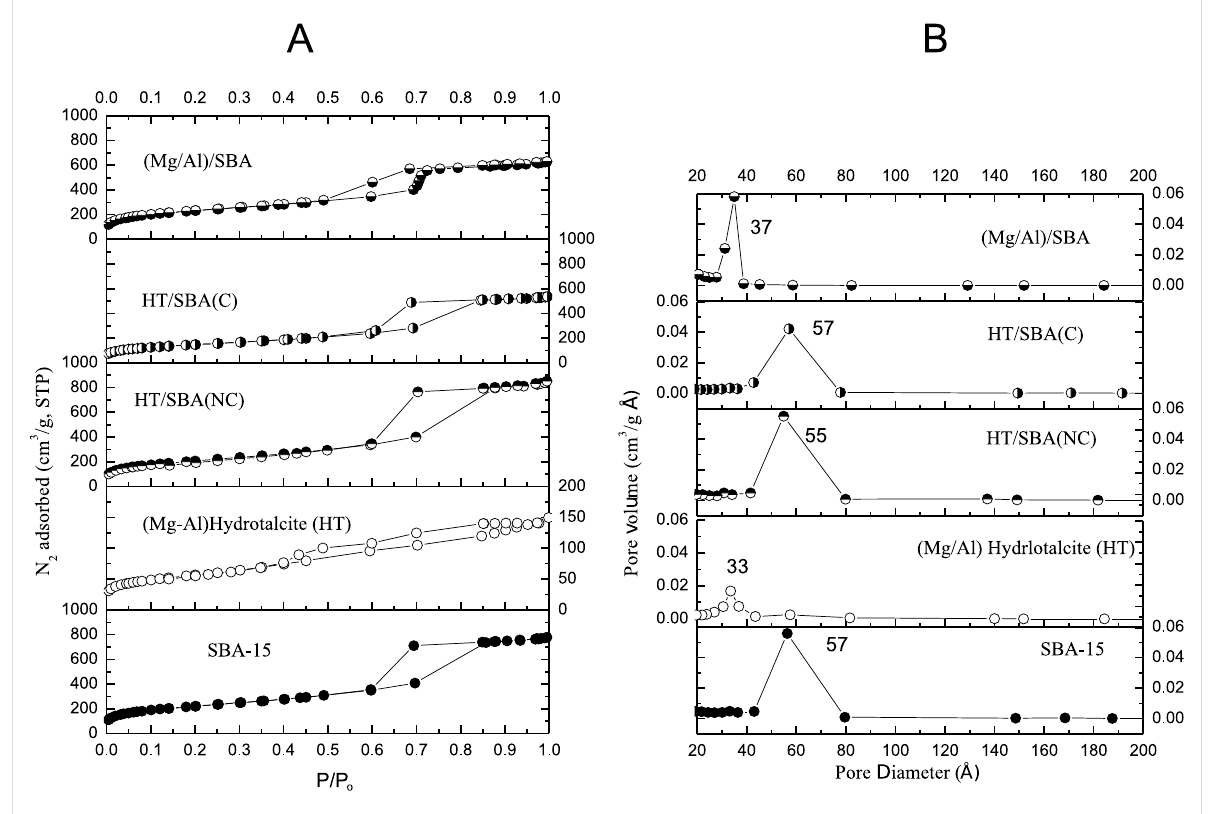
Figure 1: N 2 adsorption–desorption isotherms (A) and pore diameter distribution (B) of the composites, SBA-15 and HT.